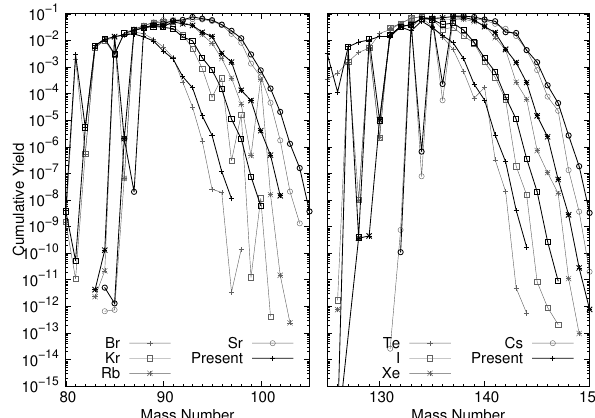
Figure 1. The three Gaussian fitted primary fission product mass Figure 2. The fitted total kinetic energy as a function of fis- yield compared with experimental data. The open squares are sion fragment mass TKE ( A ) taken from Ref. [7] compared with (cid:31) (cid:30) Langevin calculated primary fission product mass yield Y P ( A ) experimental data. The open squares are Langevin calculated TKE ( A ) and solid line is the fitting curve. taken from Ref. [7] and solid line is the result of the three Gaus- (cid:31) (cid:30) sian fitting. lytical formula. These fitting parameters were used for the the Hauser-Feshbach calculation.